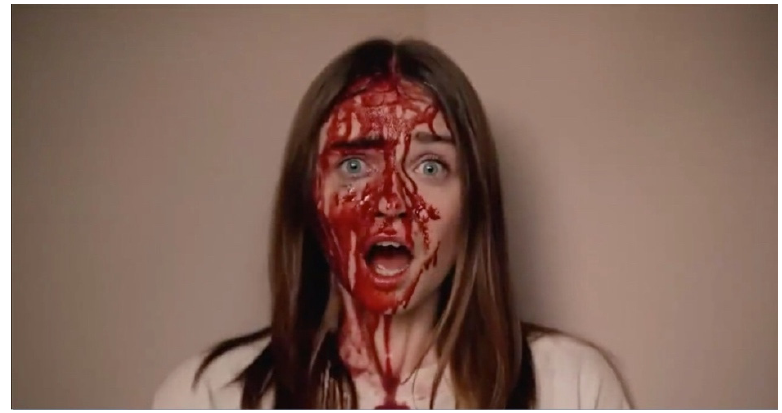
Figure 4. James’ flashforward imagination (1 × 02). Source: Clerkenwell Films .